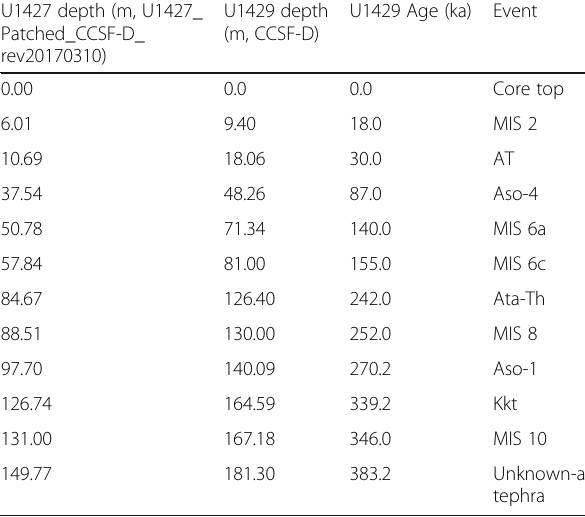
Table 3 Correlation tie points between Sites U1427 and